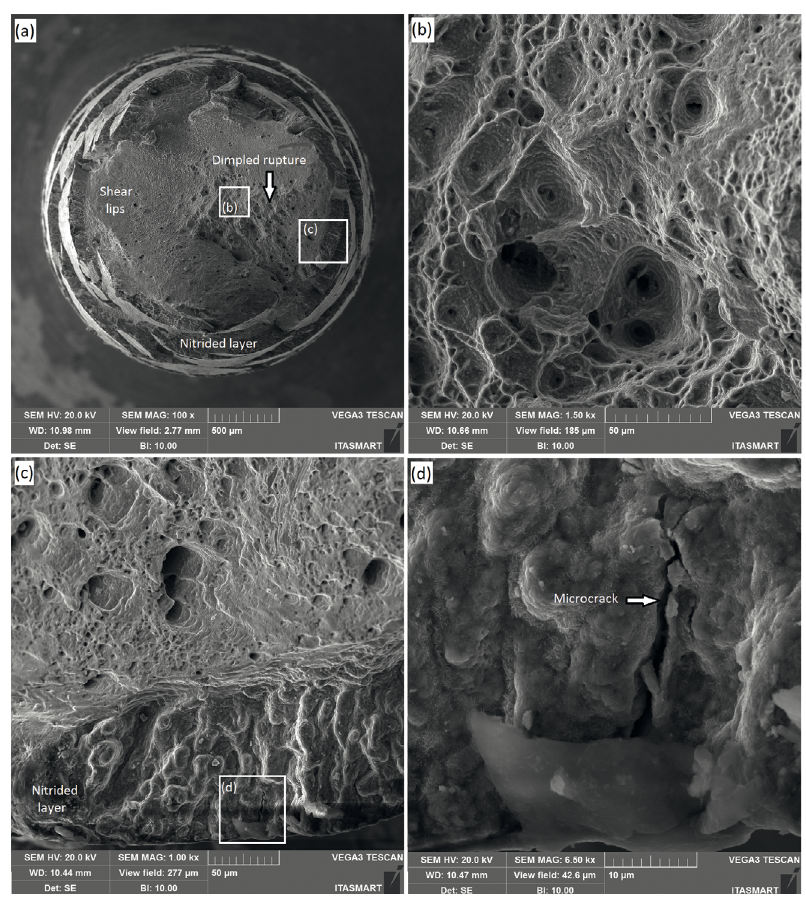
Figure 10: Secondary electron SEM images showing the fracture surface of the MAR-SAP crept at 650 ºC and 300 MPa. (a) General morphology showing a cup and cone type of failure, the enclosed areas are the location where higher magnification in Figs. 9b and 9c were taken. (b) Dimpled rupture area observed in the enclosed area marked as “b” in Fig. 9a. (c) A brittle type of fracture in the surface vicinity (nitrided layer), the enclosed area is where a higher magnification image in Fig. 9d was taken. (d) Cleavage surface and formation of microcracks close to the